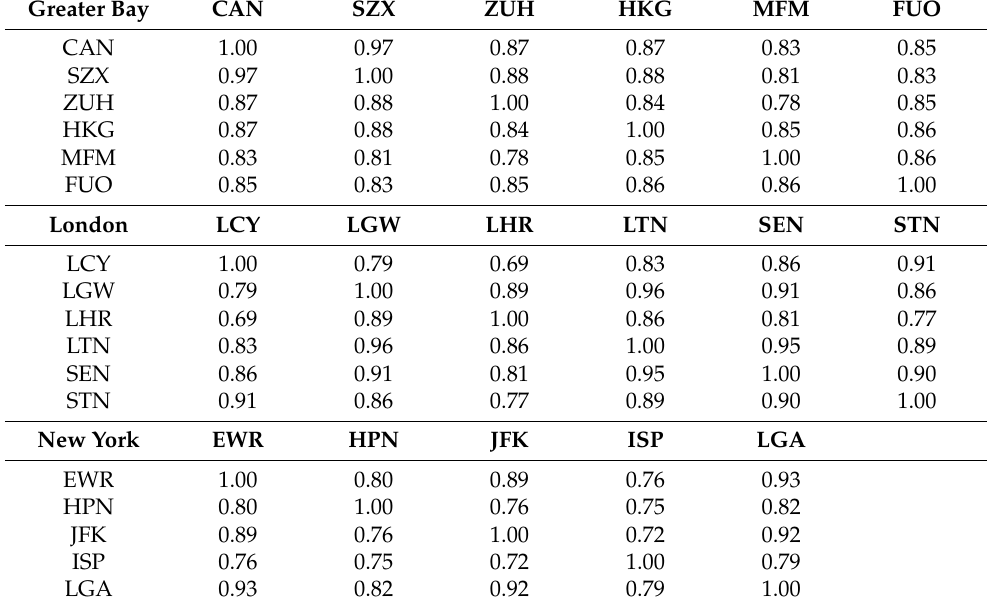
Table A3. Homogenization result of OE.